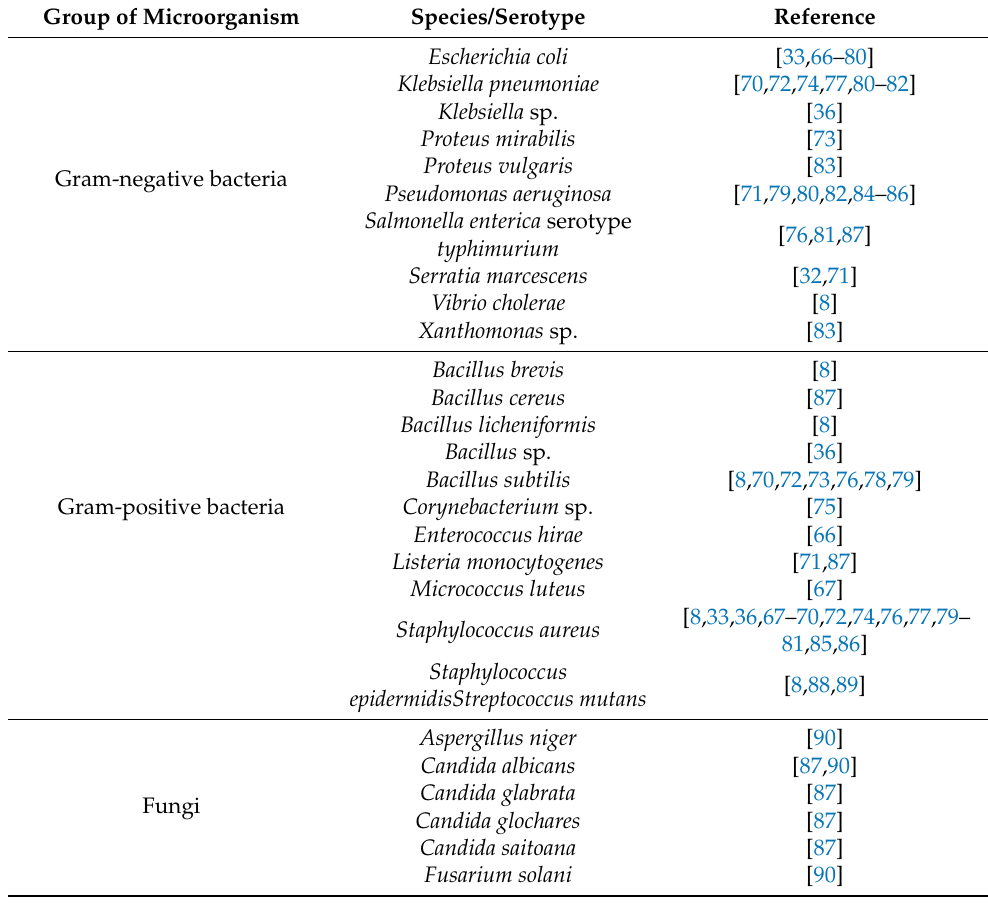
Table 1. List of the microorganisms susceptible to the toxic action of